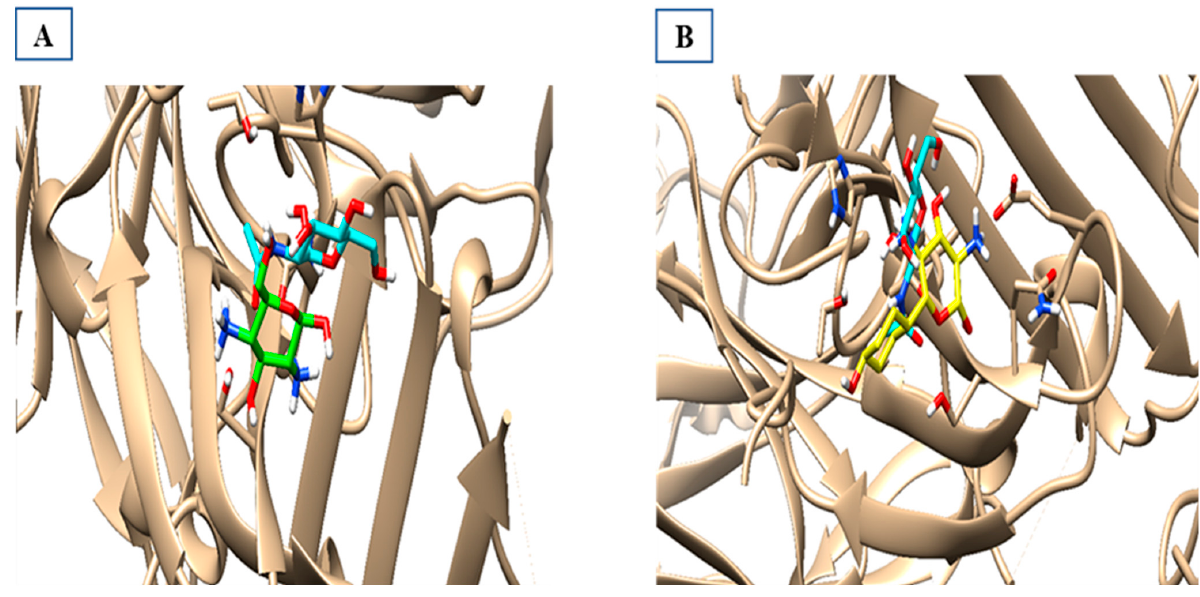
Figure 11. Superimposed models of the docked output to test the most suitable two compounds inside the binding sites of 2FD6. ( A ) The green one is compound 3, the co-crystallized ligand is cyan-colored, and ( B ) the yellow one is compound 4 superimposed with the cyan-colored co-crystallized ligand.